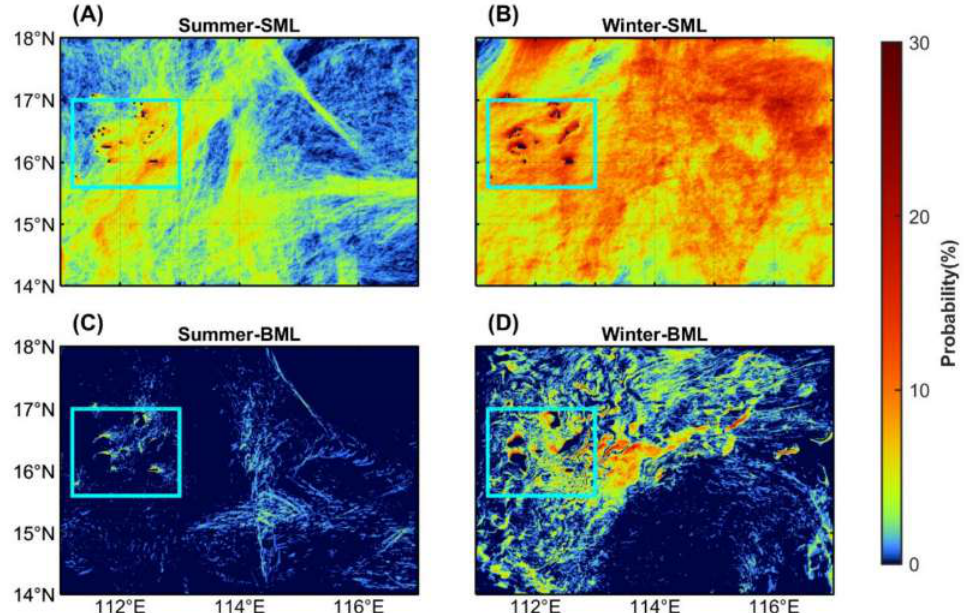
Figure 6. The occurrence probability distribution of SI activity in the ( A , B ) SML and ( C , D ) BML. The upper (lower) row shows averaged results in July (January) from 2017 to 2019, representing summer (winter). Inside the cyan rectangle are the Xisha Islands. SML, the ocean surface mixed layer. BML, the base of the surface mixed